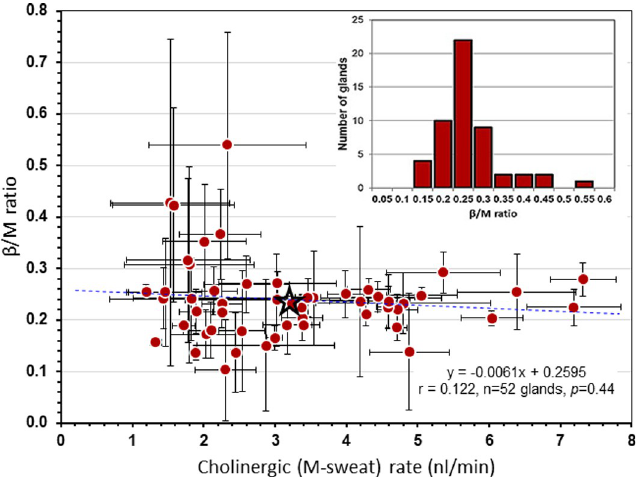
Fig 2. Within-subject sweat rates. Within-subject variation of β -adrenergic/cholinergic sweat rate ratios from each of 52 identified glands in a single subject, S-38, plotted against the cholinergic rate. For each gland, the average across all 3 tests was determined for M and C sweat rates, which was used to compute the Cav/Mav ratio for that gland. The ratio was plotted against the Mav for that gland to give the distribution shown for all 52 glands; means and SDs are plotted. Star shows the grand mean, obtained by summing the Mav from each of the 52 glands dividing by 52 to give (for this subject) 3.2 nl/min/gland. Similarly, the Cav/Mav ratio for each of the 52 glands were summed and divided by 52 for to give (for this subject), Cav/Mav = 0.23. The grand means were plotted for each of 50 subjects in Fig 3. Inset shows the distribution of β av/Mav ratios.